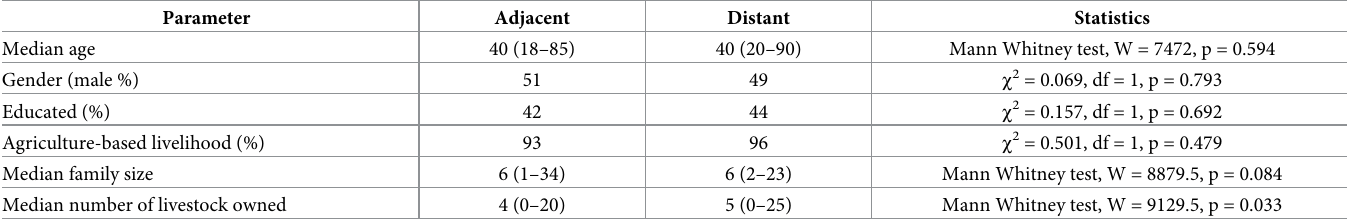
Table 1. Demographic and social information of respondents (n = 300) living adjacent ( < 500 m) and distant ( � 500 m) to Shuklaphanta National Park, Nepal. Parameters include age (years), gender (male or female), education (educated represents people who attended school through grade five or above; uneducated did not attend school), agriculture-based livelihood (people whose primary vocation is agriculture), family size (number of people), and livestock owned (number of all hoofed live- stock owned). Values in parentheses are